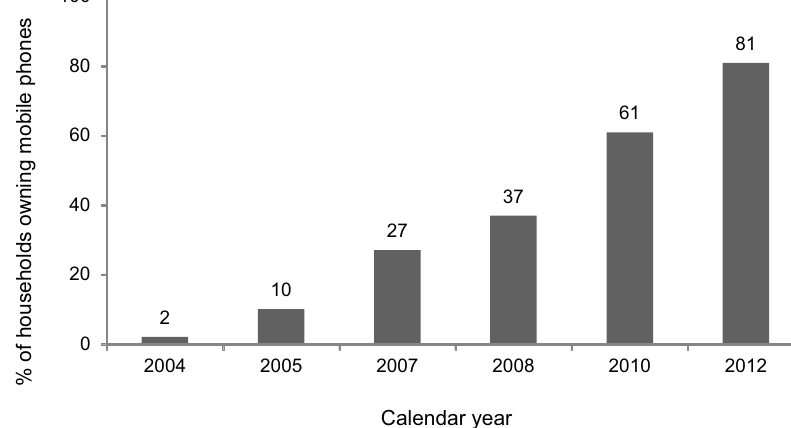
Figure 1. Household mobile phone ownership.